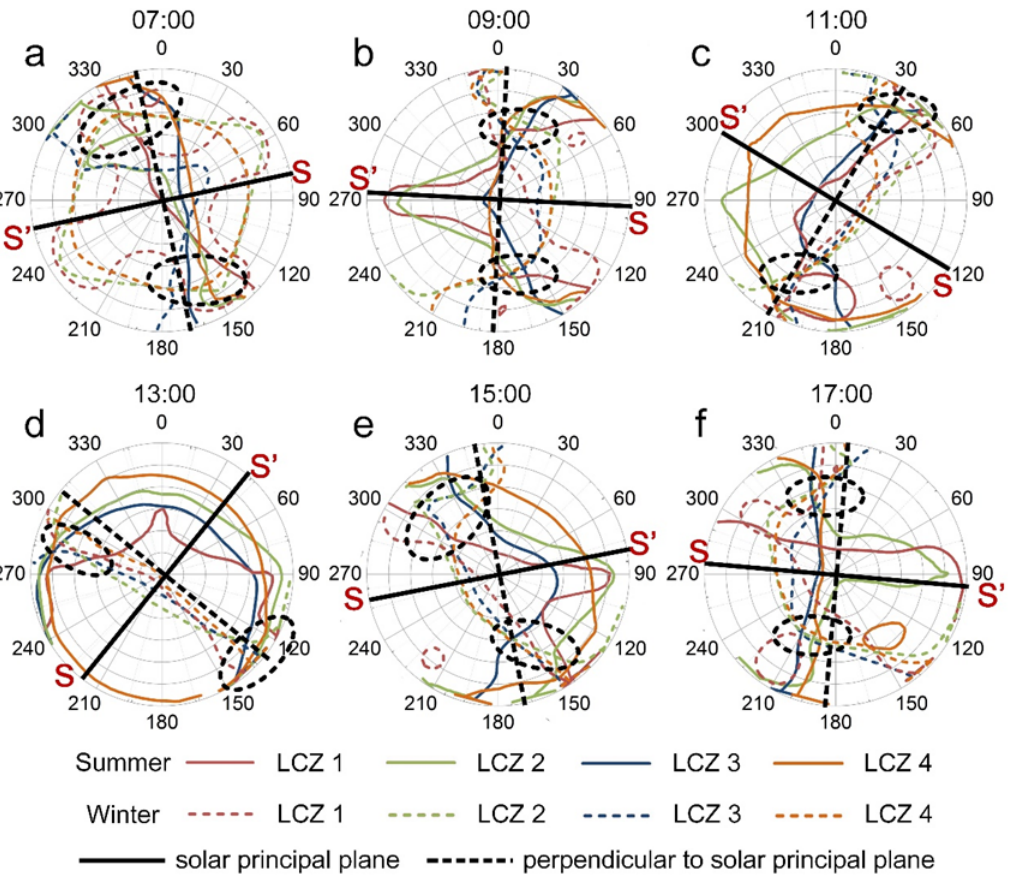
Fig.3 Contour line distribution of T c in daytime. The range of the zenith and azimuth angle is consistent with Fig.2 , and the black ellipse dotted circle is the area where the contour line is densely